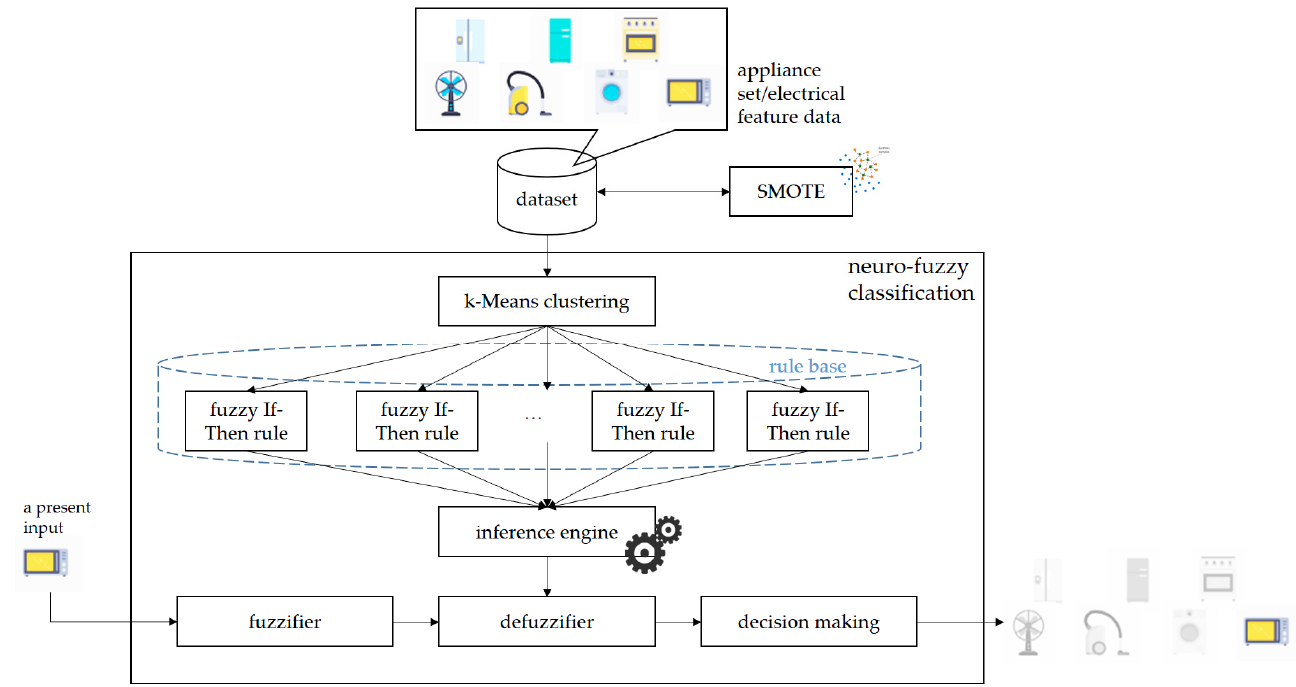
Figure 1. Structure of neuro-fuzzy classification integrated with k-Means clustering.